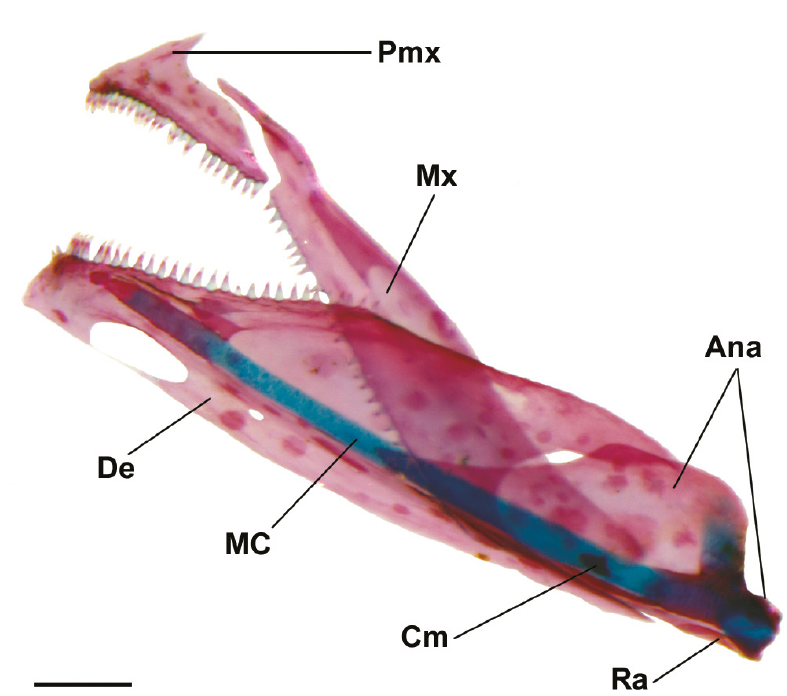
FIGURE 3 | Priocharax britzi , paratype, MZUSP 125823, 12.9 mm SL, c&s; jaws in lateral view. Ana = anguloarticular; Cm = coronomeckelian; De = dentary; MC = Meckel’s cartilage; Mx = maxilla; Pmx = premaxilla; Ra = retroarticular. Scale bar = 0.2